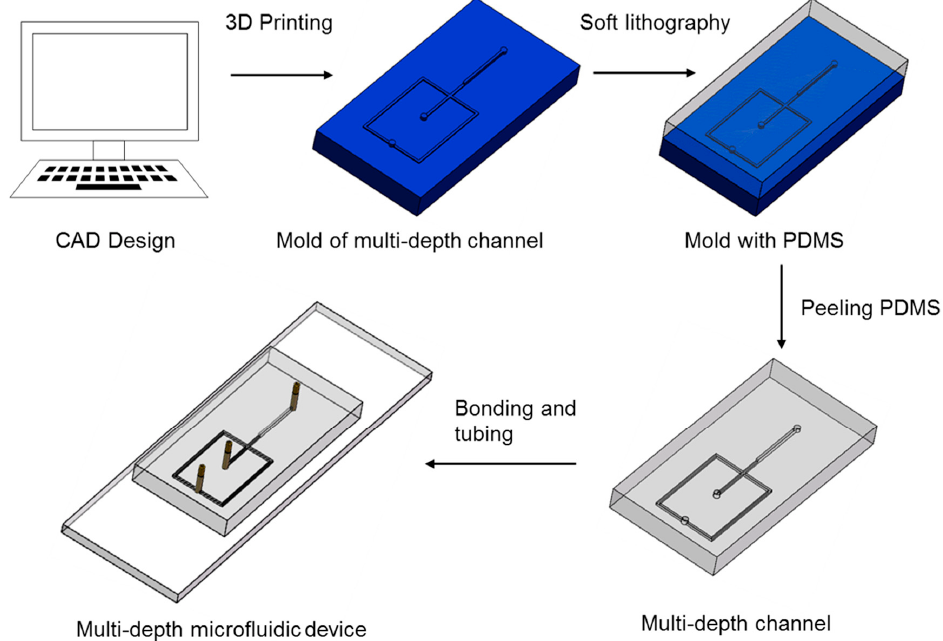
Figure 4. Fabrication flow of a multi-depth microfluidic device using LCD SLA 3D printing.